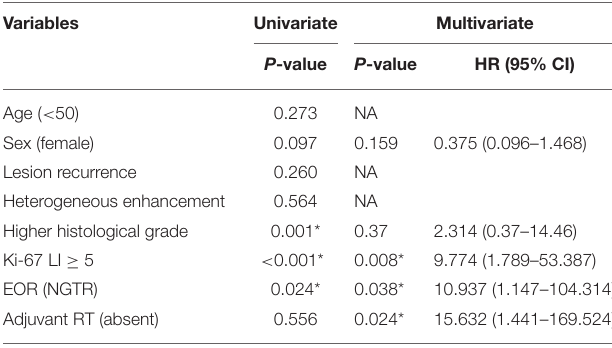
Frontiers in Oncology |